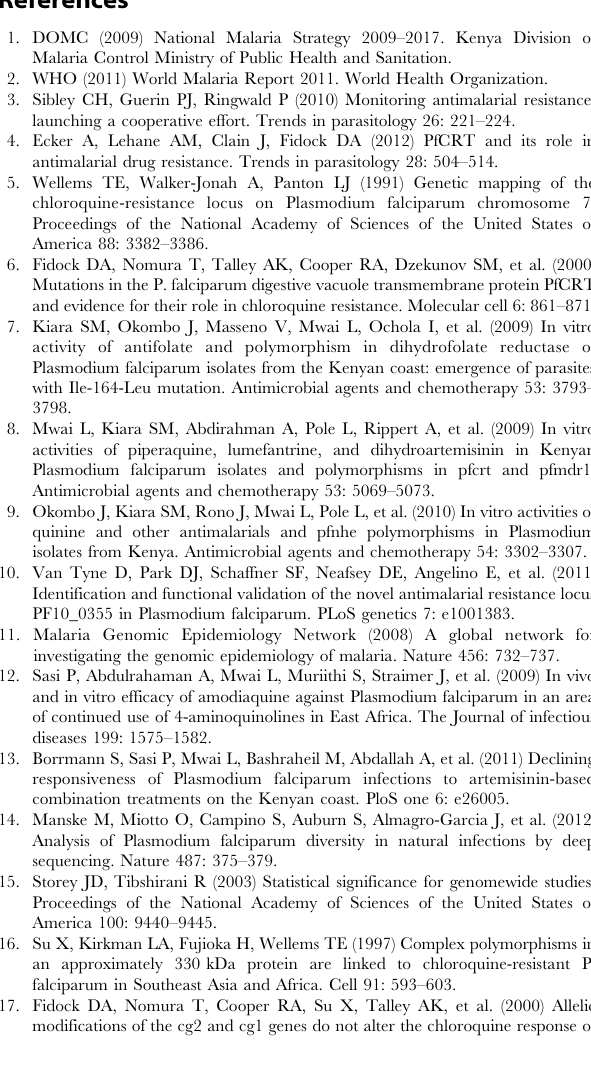
diversity is apparent in the top rows—i.e., those parasites that are most susceptible to CQ, and lack the 76T allele. Figure S10 Haplotype plot for pfcrt (MAL7P1.27). Left panel is sorted top to bottom by CQ IC 50 , and the right panel is sorted by LUM IC 50 . Each row represents a sample, and each column a potential SNP. Drug activity is shown as increasing green intensity in the far left column of each plot. Blue cells indicate positions matching the reference genome, and red the alternate allele. Mixed infections are represented by blending of red and blue, proportional to the within-sample allele frequencies. White cells indicate missing data. Nonsynonymous SNPs are labeled with the amino acid substitution along the bottom, and with a dot if synonymous. Table S1 List of drugs and abbreviations used in this study. (DOCX) Table S2 Amino acid haplotypes of hallmark variants in pfdhps and pfdhfr . Column ‘N’ is the number of samples in this study represented by that haplotype.